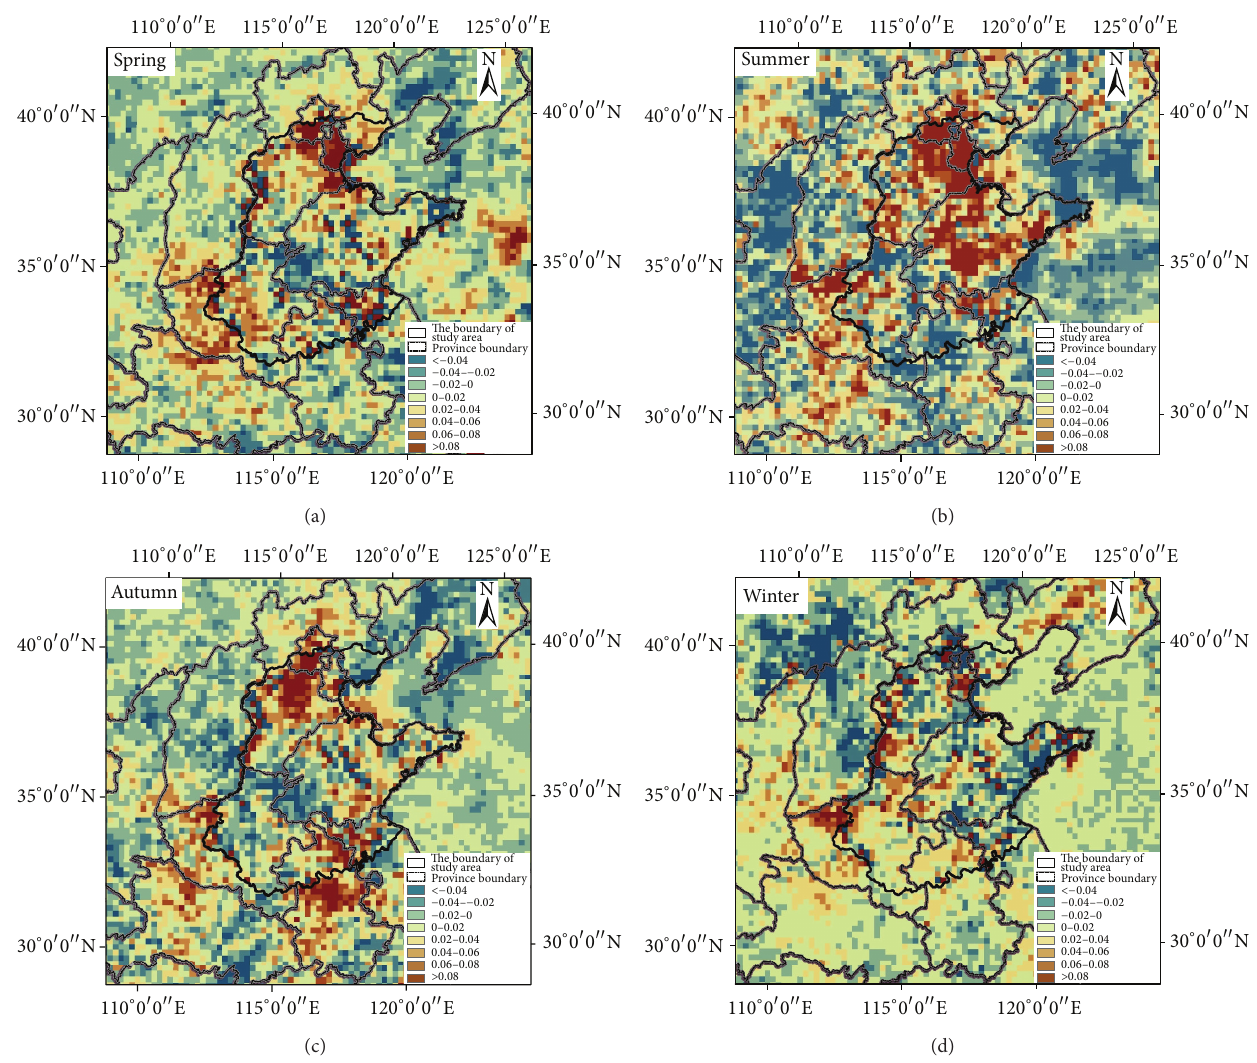
Figure 8: Difference between the near-surface temperature in the four seasons in the sensitivity test and control test (Unit: ∘ C).